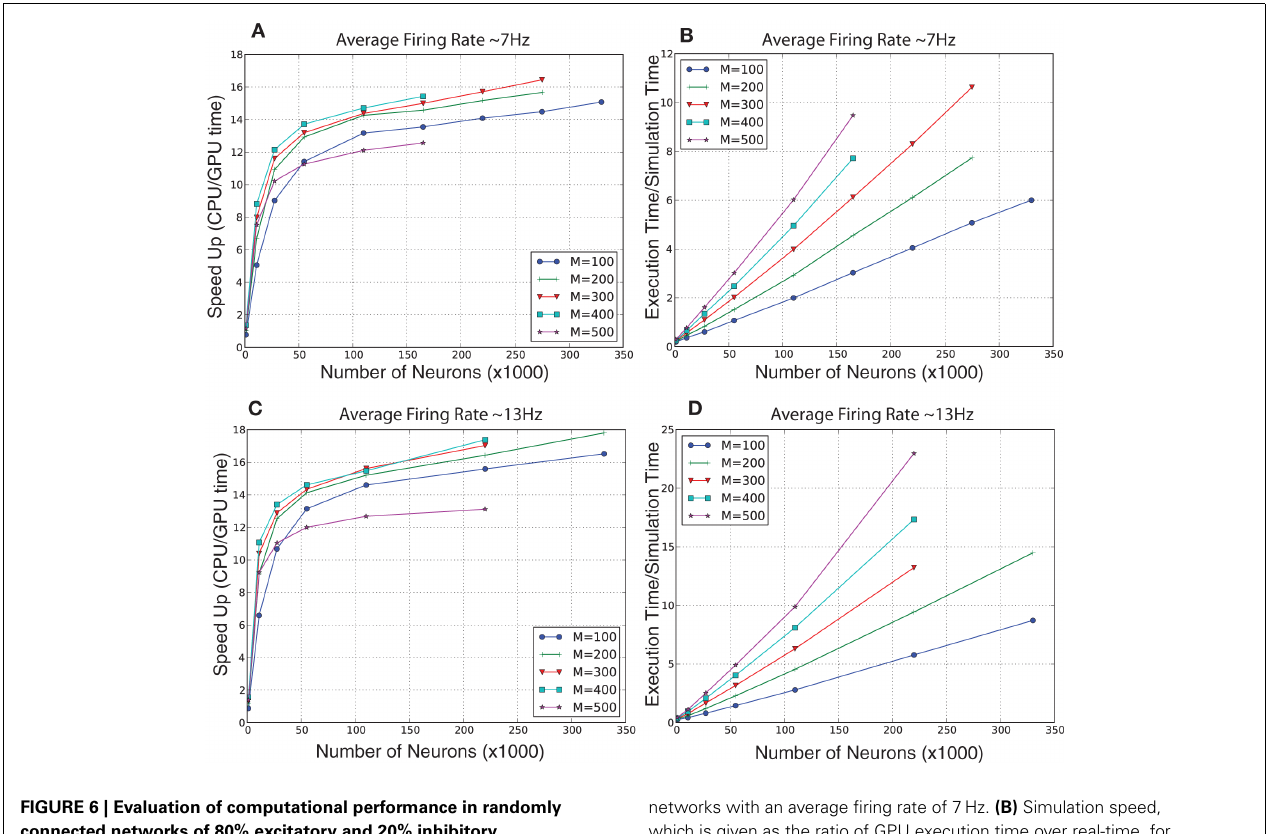
FIGURE 6 | Evaluation of computational performance in randomly connected networks of 80% excitatory and 20% inhibitory neurons. An additional 10% of the neurons were Poisson spike generators that drove network activity.The number of neurons in the networks tested were 1,100, 11,000, 27,500, 55,000, 110,000, 220,000, and 330,000. M denotes the number of synapses per neuron. (A) Speedup, which is given as the ratio of CPU to GPU execution time, for